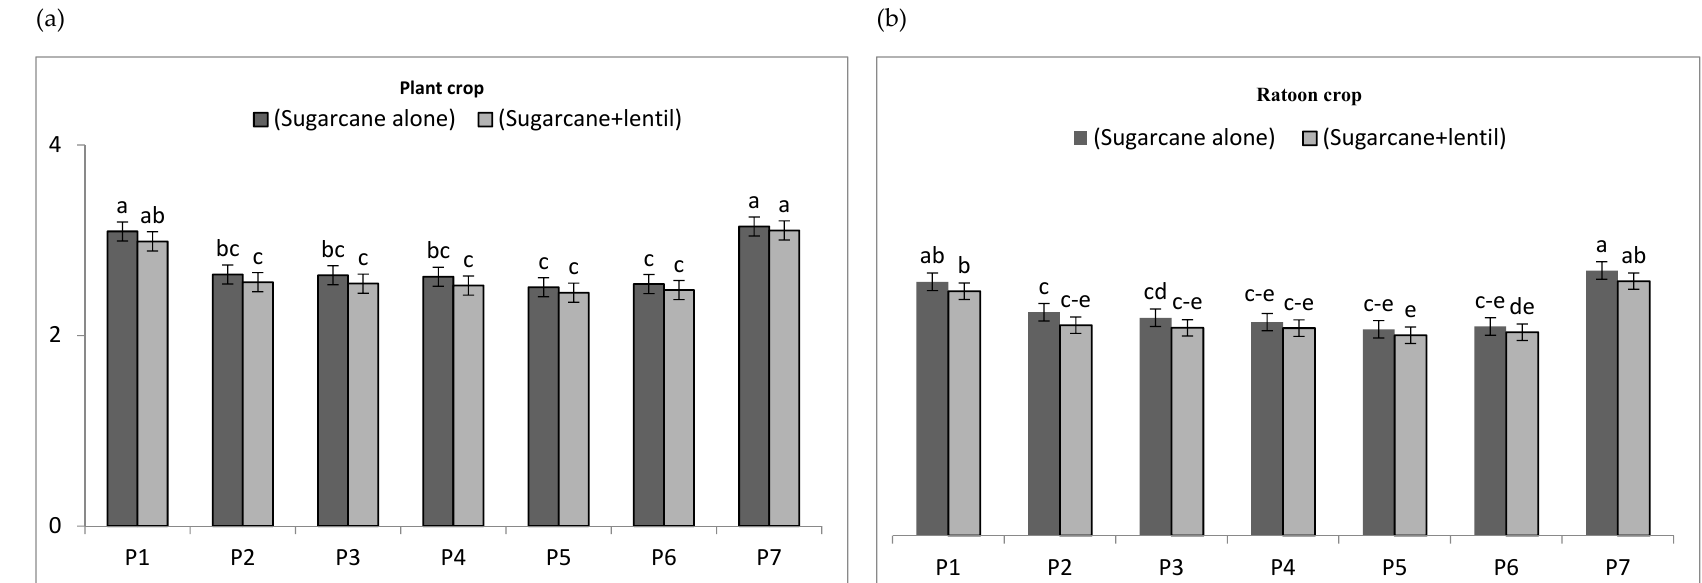
Figure 6. Net assimilation rate (g m − 2 day − 1 ) of sugarcane as influenced by various planting patterns and lentil intercropping in ( a ) Plant crop and ( b ) ratoon crop. P 1 : 45 cm pits with 90 cm diameter, P 2 : 60 cm pits with 90 cm diameter, P 3 : 75 cm pits with 90 cm diameter, P 4 : 90 cm pits with 90 cm diameter, P 5 : 60 cm single rows planting, P 6 : 90 cm double rows planting, P 7 : Trench planting at 120 cm. Any two means not sharing a common letter(s) differ significantly at 5% probability.